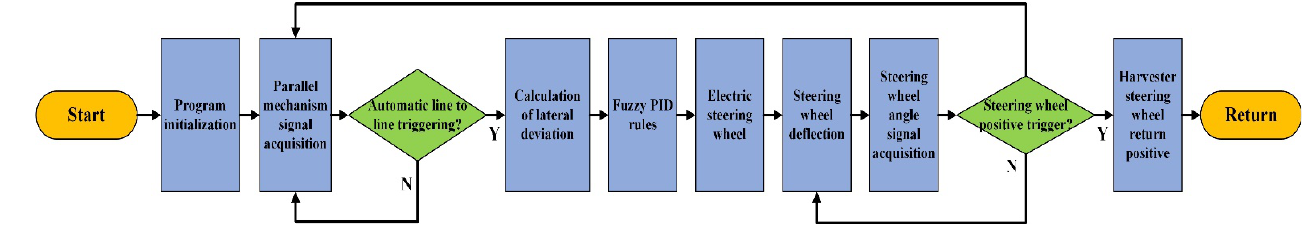
Figure 8. Control flow diagram of automatic alignment system.